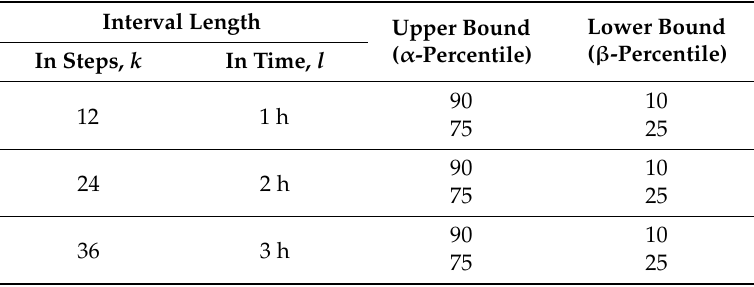
Table 3. Interval lengths and bounds for 2D-interval